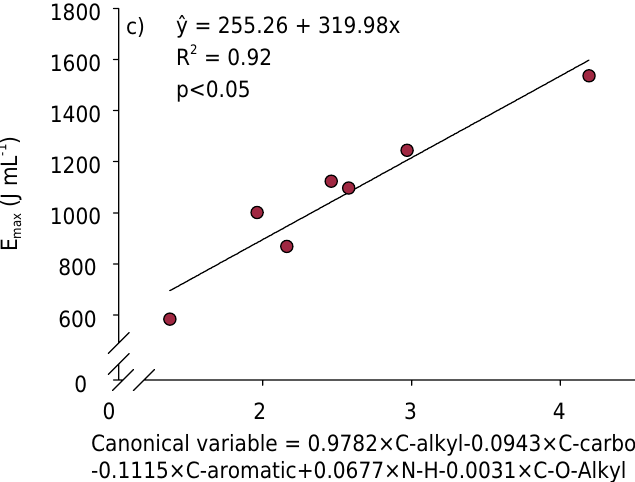
Figure 8. Linear regressions between the canonical variable and the ultrasound energy levels in a) OX, b) FH, and c) TS.